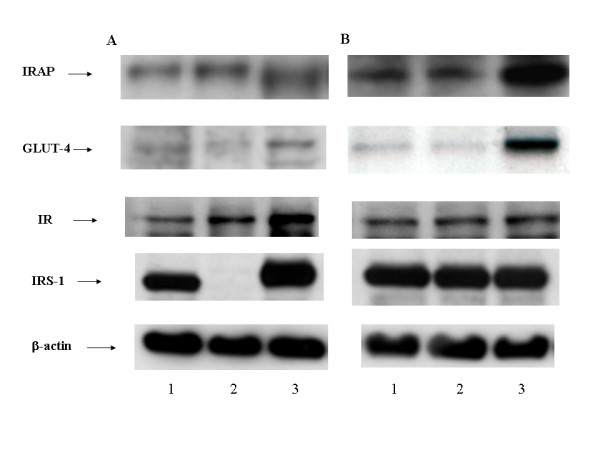
A. Expressions of P-LAP/IRAP, GLUT4, IR, and IRS-1 in three endometrial carcinoma cell lines. Lanes are as follows: lane 1, A-MEC cells; lane 2, HEC-1A cells; lane 3, Ishikawa cells. B. The effect of P-LAP/IRAP transfection on GLUT4, IR, and IRS-1 expressions in A-MEC cells. Lanes are as follows: lane 1, A-MEC cells; lane 2, A-MEC-pc cells; lane 3, A-MEC-LAP cells.